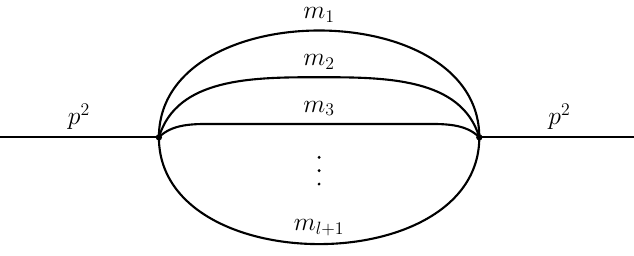
Figure 1 . The l -loop banana graph with external momentum p and internal masses m i